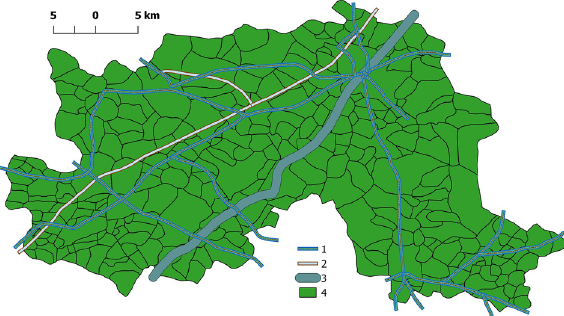
Fig. 6. Road Network Analysis for Gurugram district. 1 – road network, 2 – railway line, 3 – 200 m buffer around national highway (NH-8), 4 – Gurugram district boundary.